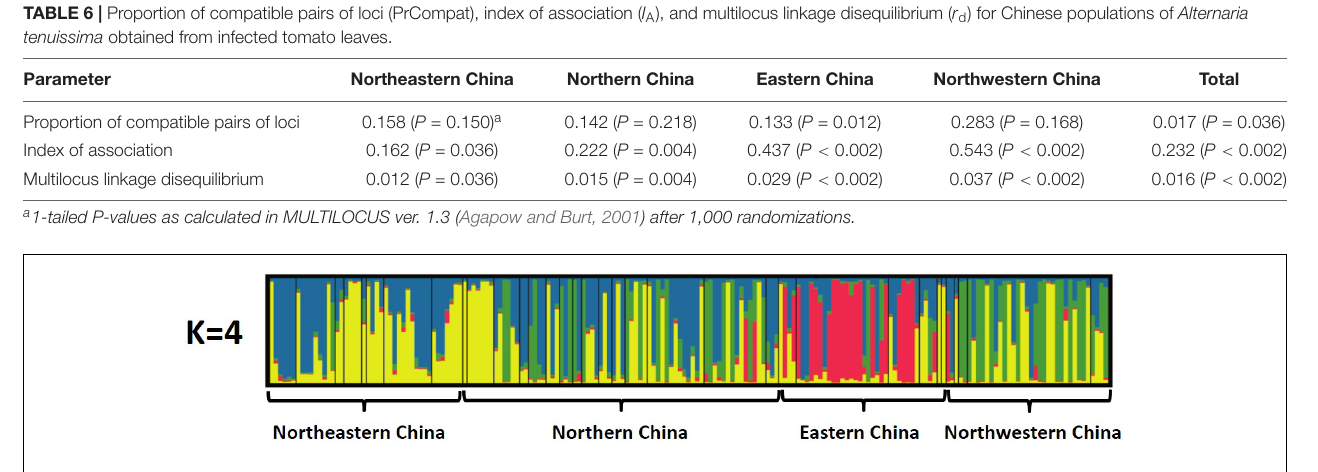
FIGURE 5 | Population structure of A. tenuissima based on 16 microsatellites (different shadings represent different genetic groups; each column represents an individual isolate, and the height of the column segments shows the probability of assignment of this isolate to a particular genetic group. The height of each shaded region within an individual bar is the measure of proportional affiliation. When K = 4, q 1 red, q 2 green, q 3 yellow, q 4 blue, individuals with membership coefficients of q i ≥ 0.7 were assigned to a specific genetic cluster).